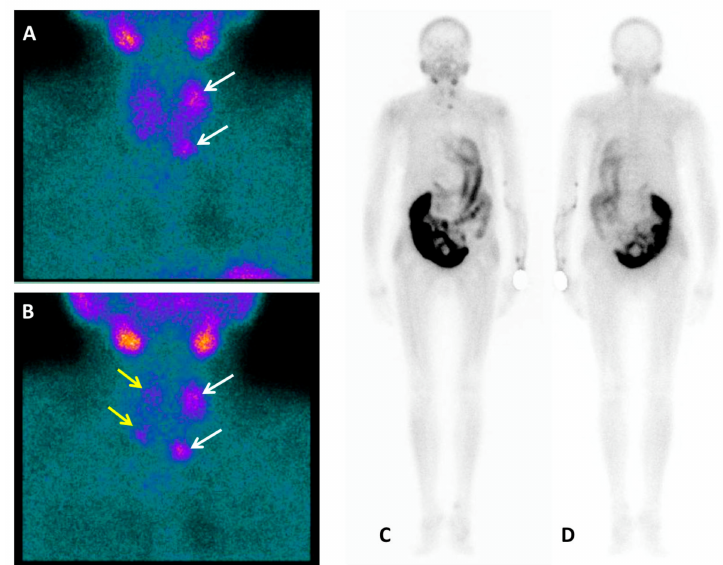
Figure 1. A nephrectomised 62-year-old woman with chronic renal failure (stage 5D, Kidney Disease Improving Global Outcomes (KDIGO)) [1] in dialysis treatment since 2012. Listed for kidney transplantation, laboratory tests were consistent with severe hyperparathyroidism: Parathyroid hormone (PTH) level 2068 pg / mL (normal range 15–57 pg / mL), total calcium level of 7.7 mg / dL (normal range 8.5–10.1 mg / dL), ionized calcium level of 3.49 mg / dL (normal range 4.6–5.3 mg / dL) and inorganic phosphate level of 3.7 mg / dL (normal range 2.5–4.9 mg / dL). Then, patient performed neck ultrasound (US) and, for the recent occurrence of dorsal back pain, a whole-spine magnetic resonance (MRI). According to tertiary hyperparathyroidism (HPT) diagnosis [2] the nuclear medicine imaging workup before surgery consisted of Tc-99m-methoxyisobutylisonitrile (Tc-99m-MIBI) and Tc-99m-methylenediphosphonate (Tc-99m-MDP) planar scintigraphy, completed with Single Photon Emission Computed Tomography / Computed Tomography (SPECT / CT), and 18 F-FCH PET / CT. Tc-99m-MIBIparathyroiddual-phaseplanarscintigraphy(anteriorview)showedontheearlyacquisition ( A ) a left superior hyperfunctioning parathyroid gland together with a left inferior one slightly under the lower third of the left thyroid lobe (white arrows). The delayed acquisition ( B ) demonstrated, after thyroid gland radiotracer washout, persistent uptake in left parathyroid glands and a mild Tc-99m-MIBI concentration also in the other two right glands (yellow arrows). Planar scintigraphy was integrated with a whole-body acquisition [3] because of the detection of lytic bone lesions on the whole-spine MRI, performed a few days before, doubtful for renal osteodystrophy, giant cell bone tumour, or carcinoma. No Tc-99m-MIBI uptake was found in the bone as showed in the whole body anterior ( C ) and posterior ( D ) planar views. Then, patient was directed to Tc-99m-MDP bone